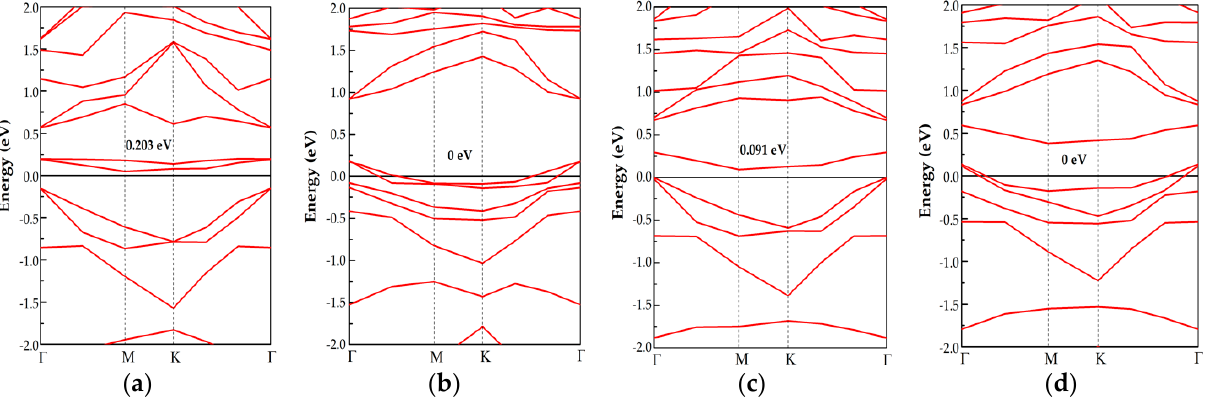
Figure 6. Energy band structure of ( a ) Pd-C 3 N monolayer and ( b ) Pd-C 3 N/NO, ( c ) Pd-C 3 N/NO 2 , ( d ) Pd-C 3 N/SO 2 systems.